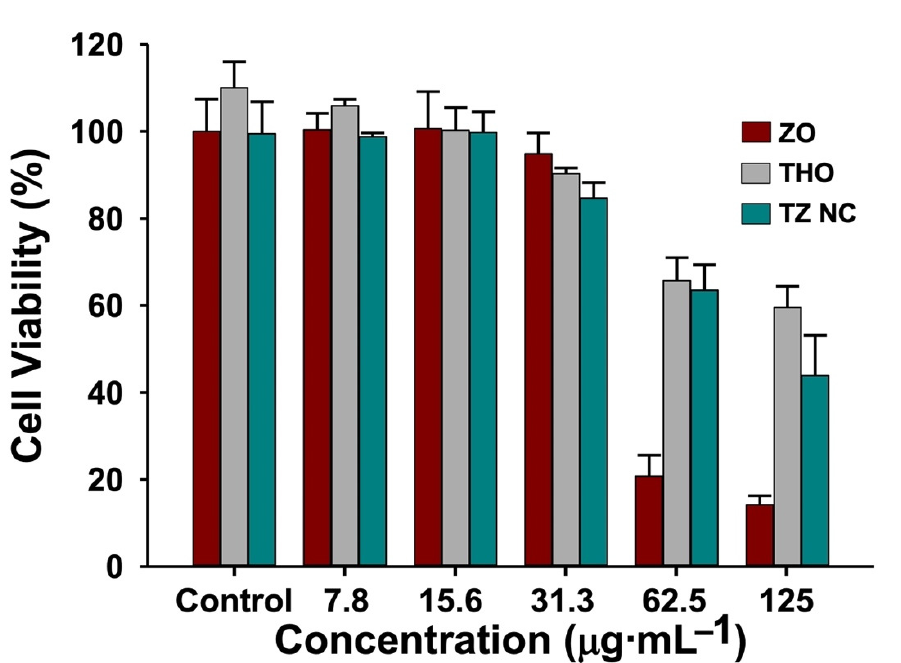
Figure 6. Biocompatibility assays. WST assays were performed to determine the viability of HCT116 cells in the presence of various concentrations of ZO, THO, and TZ NC after 24 h. The values shown in the graphs are averages of n = 3 with standard deviation ( p < 0.05). Data were analyzed using GraphPad Prism 8 (GraphPad Software, Inc., San Diego, CA, USA).